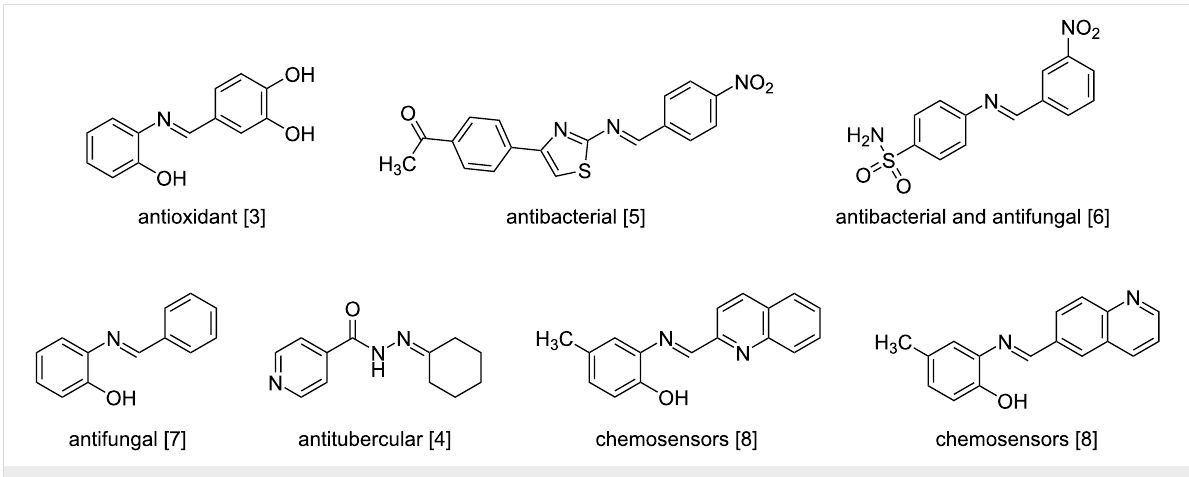
Figure 1: Examples of structures and properties of Schiff bases of interest in the present